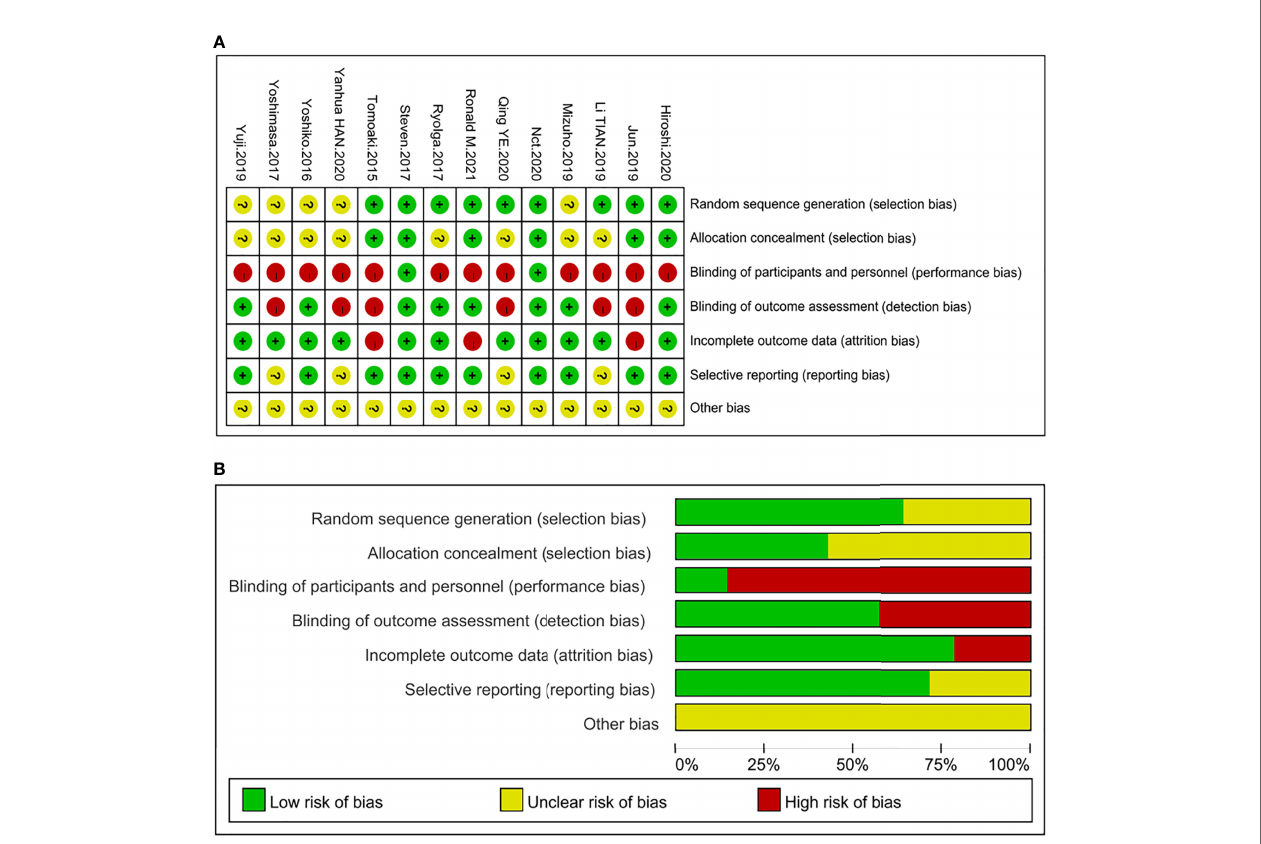
FIGURE 2 | Summary of quality evaluation based on the Cochrane ’ s Risk of Bias Tool. (A) Risk of bias summary for each risk of bias item for each included study; (B) Risk of bias graph for each risk of bias item presented as percentages across all included